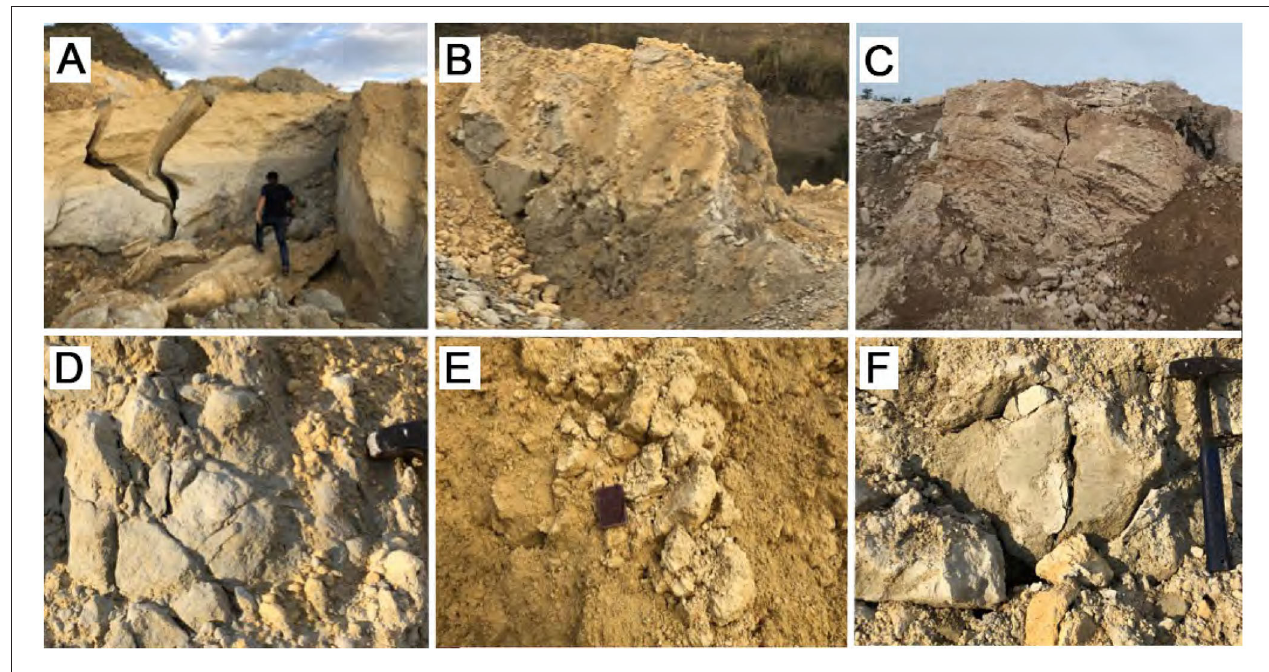
FIGURE 7 | (A–F) Boulders and blocks with jigsaw cracks.